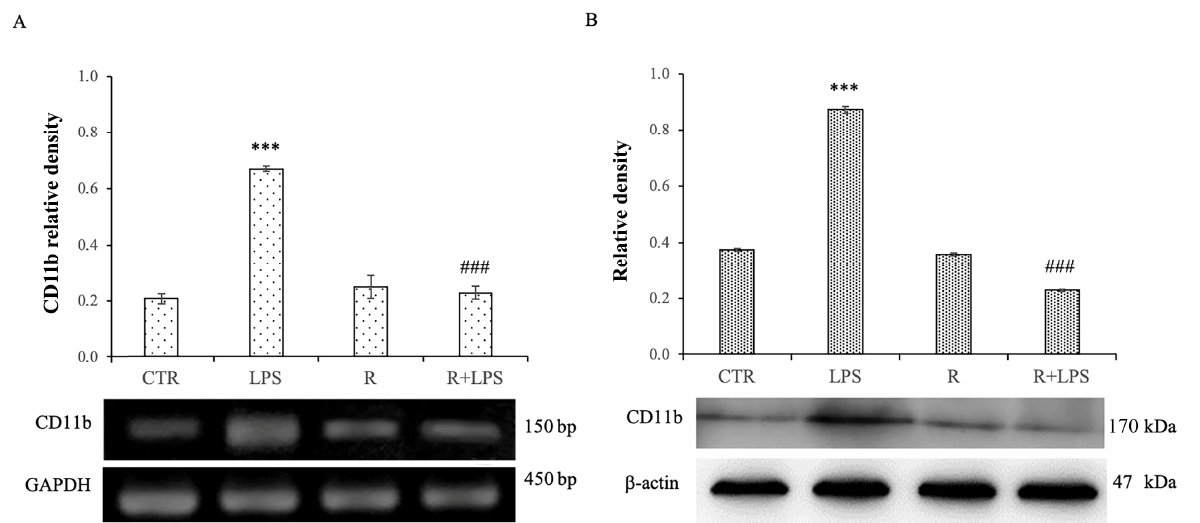
Figure 2. Effects of resveratrol on CD11b expression levels in N13 microglial cells treated with LPS for 72 h. ( A ) PCR analysis of CD11b mRNA expression levels in controls (CTR), N13 cells treated with resveratrol (10 μ M) (R), LPS (100 ng/mL) (LPS), LPS, and resveratrol (R + LPS). Results are presented as arbitrary units after normalization against GAPDH, which was used as the resident control. ( B ) Western blotting detection and densitometric analysis of CD11b levels in the microglial cells of control (CTR), LPS (100 ng/mL), resveratrol (10 μ M) (R), and resveratrol plus LPS (R + LPS). Protein expression analysis values are expressed as arbitrary units after normalization against β - actin, which was used as a loading control. Data are presented as means ± SD of five independent experiments. *** p < 0.001 LPS vs. CTR; ### p < 0.001 R + LPS vs. LPS.